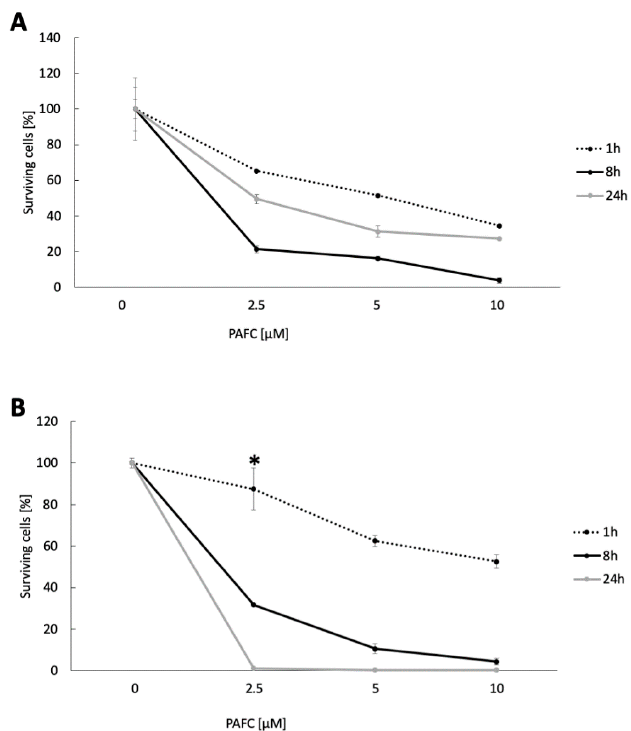
Figure 6. Candidacidal activity of PAFC. CFU of ( A ) C. albicans fluS and ( B ) C. albicans fluR cells after PAFC treatment (2.5–10 μ M) for 1 h, 8 h and 24 h. Untreated cells served as growth control and the CFU counts were set to be 100% surviving cells. The mean ± SD (technical quadruplicates of one representative experiment out of two biological replicates) is shown. A two-sample Student’s t-test was applied to calculate the significant difference between the treated samples compared to the untreated growth control ( p ≤ 0.005 for all values shown, except for * p < 0.1).